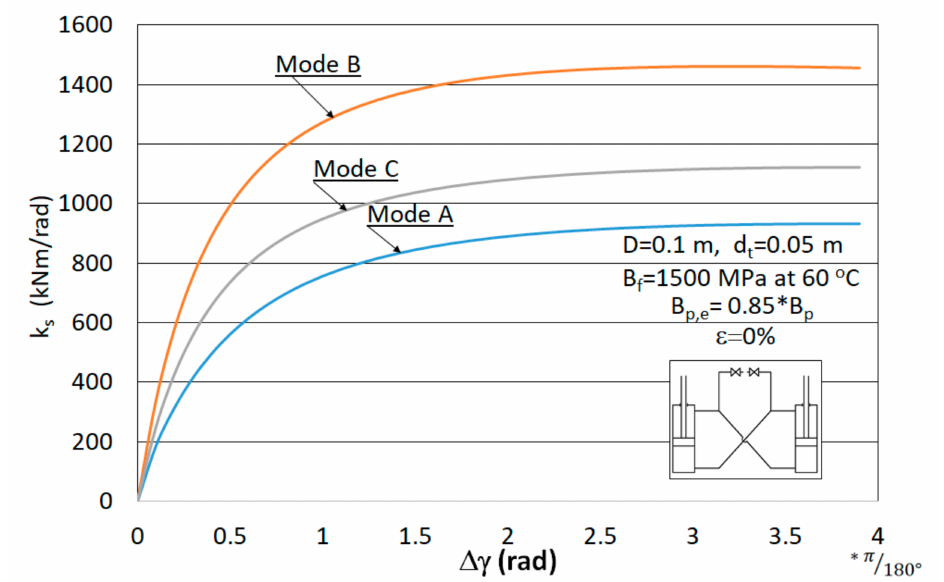
Figure 19. Influence of the configuration of hydraulic cylinders of the steering mechanism on its torsional stiffness k s